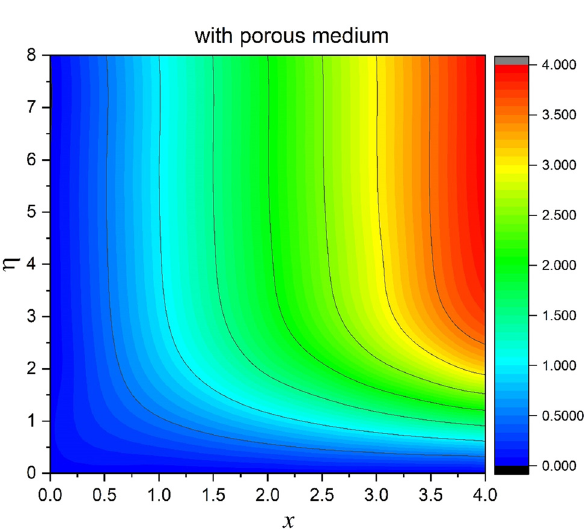
Figure 16: Streamline pattern when porous medium is